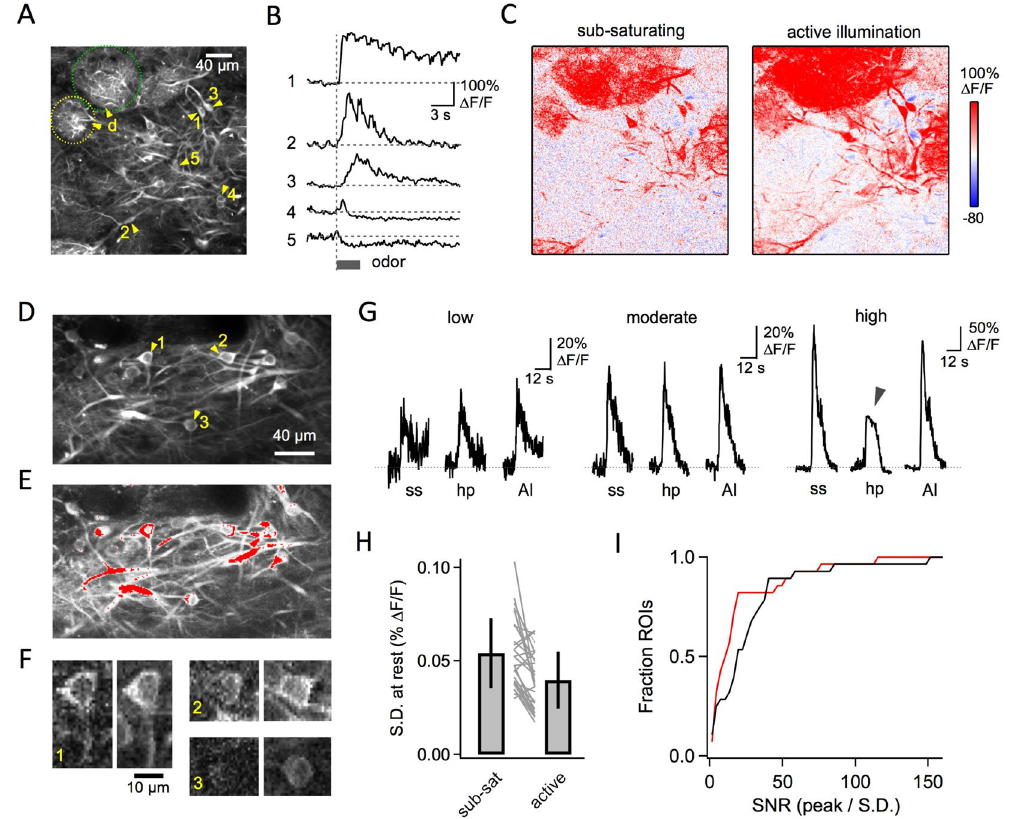
Figure 5. Improved functional imaging of neural activity with active illumination. ( A ) Mitral/tufted cells and dendrites in the olfactory bulb of Thy1-GCaMP3 mice (3.2 μ s pixel time – Supplementary Videos 3–5). ( B ) Sensory responses to odors for selected ROIs (arrowheads) exhibit both increases and decreases in activity spanning a wide intensity range. ( C ) Activity maps showing average Δ F / F 0 during the 5 sec period after odor stimulation: when the laser power is limited to prevent saturation, activity maps primarily reflect only the strongest-responding structures (left); when the laser power is increased with AI, the improved SNR enables the detection of smaller changes in soma and dendrites, providing a more detailed identification of activity across the neural population (right). ( D,E ) Increasing laser power alone leads to detector saturation in many areas, where red identifies pixels clipped at any time during the image sequence (3.2 μ s pixel time – Supplementary Videos 6–8). ( F ) Increased image quality with AI, shown for three example neurons in single imaging frames prior to odor stimulation. ( G ) Comparison of sensory responses in 3 different neurons with and without AI, showing cells with low, moderate, and high activity levels. AI prevents clipping at higher illumination intensity (right, arrowhead). ( H ) On average, AI gave a ~30% reduction in resting noise levels of individual ROIs. ( I ) Cumulative SNR histograms showing rightward shift toward higher SNR with AI (black) compared to without AI (red). SNRs were calculated for each ROI as peak Δ F / F 0 during the odor response divided by the standard deviation (SD) of the resting